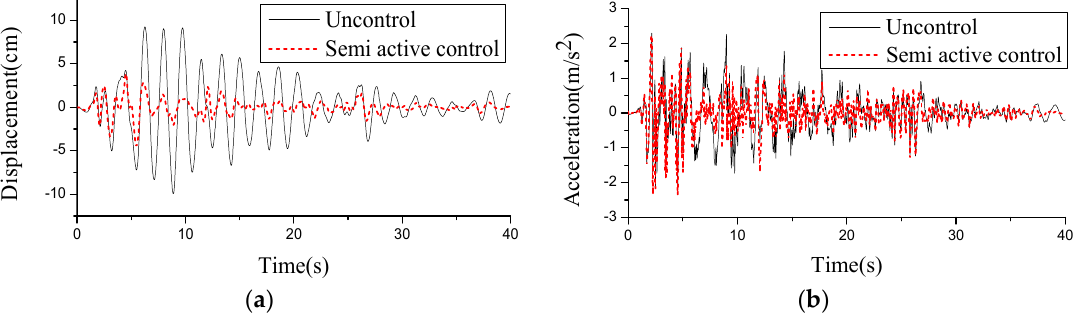
Figure 6. Time–history curve of the main beam under the action of El Centro seismic wave: ( a ) displacement; ( b ) acceleration.